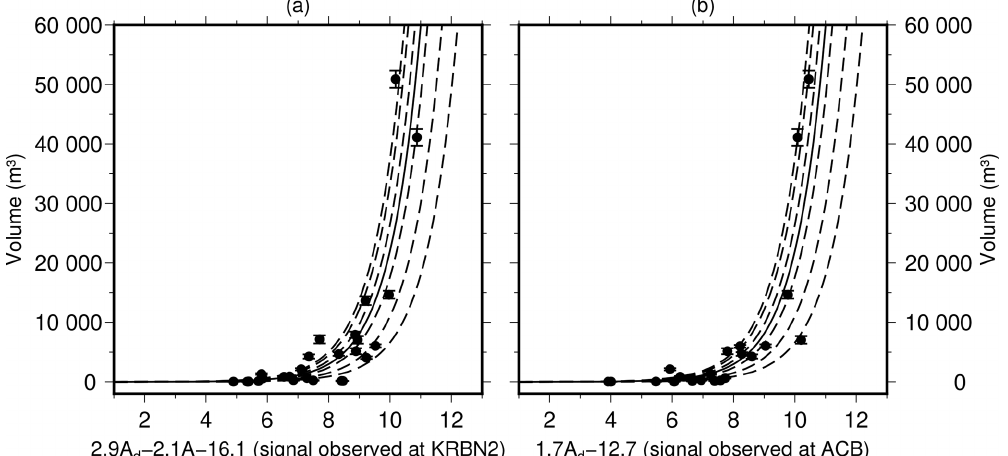
Figure E1. Best-performing GLMs for KRBN2 and ACB. Symbols show calibration data from lidar measurements with error bars. Solid curve represents the fitted model. Dashed lines show deviations of ± 20%, 50%, and 70% for a given volume. A d is the logarithm of envelope amplitude integrated over calving signal duration and A the logarithm of maximum envelope